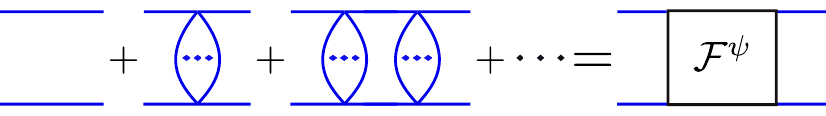
Figure 2 . Leading contributions to \gauge invariant four point function" in large N